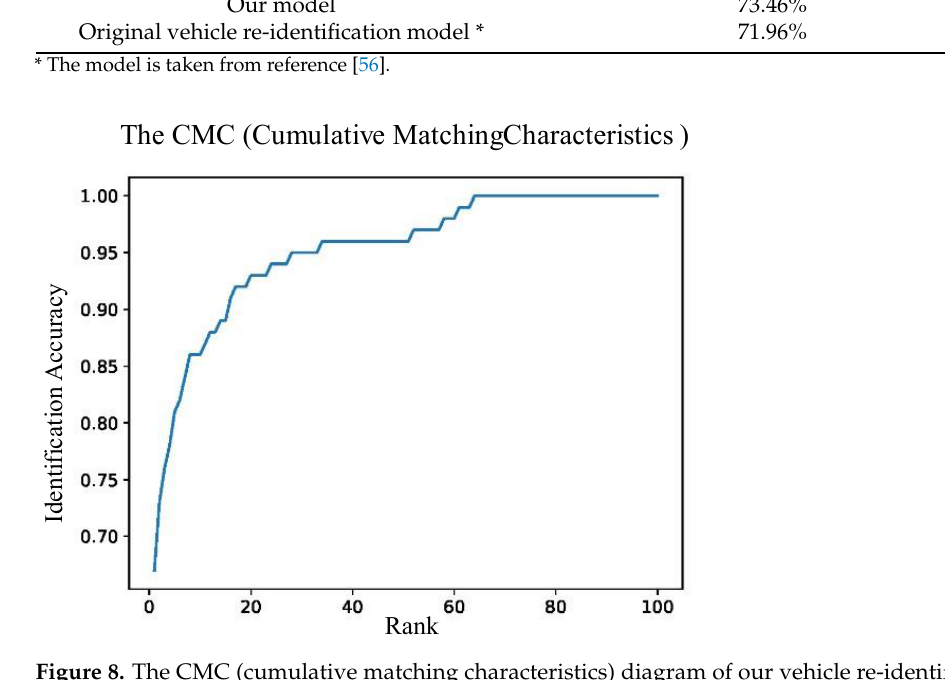
Figure 8. The CMC (cumulative matching characteristics) diagram of our vehicle re-identification model fused with lane features. Table 2. Evaluation indicators of our vehicle re-identification model fused with lane features.